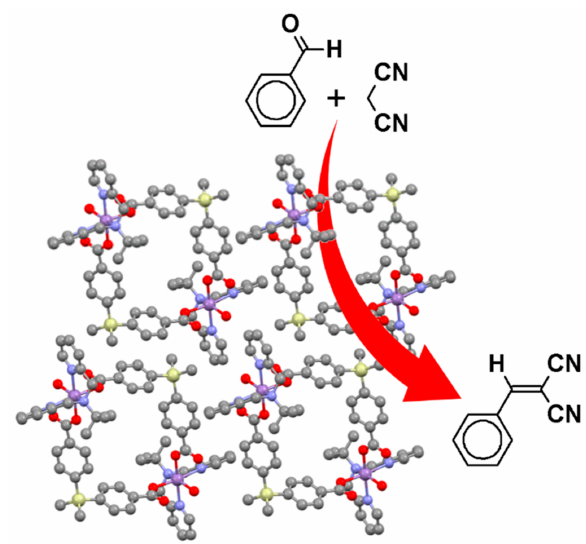
Figure 53. Catalytic Knoevenagel condensation between malononitrile and benzaldehyde catalyzed by discrete [2+2+2] molecular squares in a water environment (see CCDC reference number